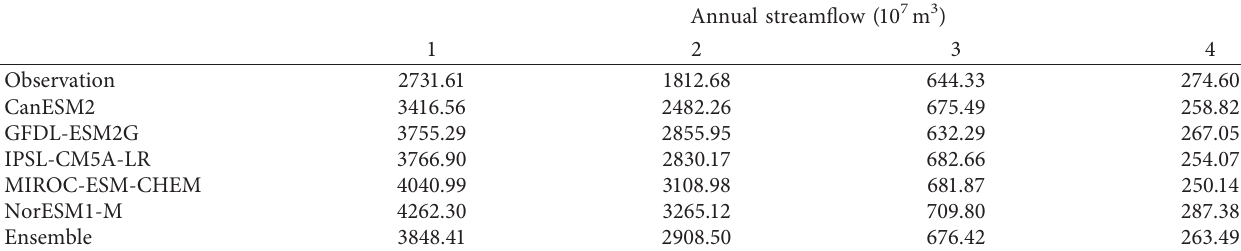
Figure 7: Q-Q plots of (a) annual runoff and (b) daily streamflow for Station 3. Table 7: Annual streamflow statistics simulated using the five GCMs for the historical period and